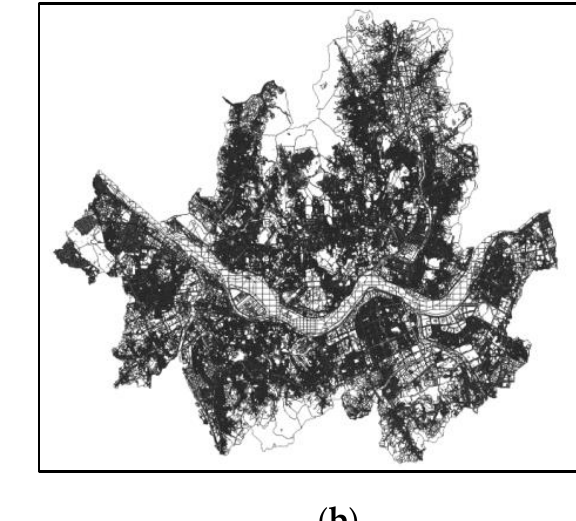
( b ) Figure 4. Map of Busan, Korea: ( a ) Administrative districts [34]; ( b ) vector image on a GIS application . 3.2.2. Depot Locations In the two cities, depot locations are based on UDCs, hub terminals for national postal services, and some large shopping malls. Deliveries starting from the UDCs or postal hubs are reasonable from a logistics point of view, but setting a shopping mall as depot location may seem contrary. However, this reflects the booming demand in last-mile delivery ser- vices, which have increased significantly during the COVID-19 pandemic. The spatial data for the depot locations are obtained from shared data produced by various public institutions in Korea. Locations for UDCs, postal hub terminals and mega shopping malls are shared by the Korean National Logistics Information Center. Spatial data for postal hub centers and shopping malls are from the Korean Ministry of Science and ICT (Information and Communications Technology) and the Korean Land and Geo- spatial Informatrix Corporation, respectively. In Figures 5 and 6, large markets are denoted as blue squares. Among them, one for Seoul and one for Busan are randomly chosen for the benchmark creation. Similarly, for the UDCs and postal hubs, one of each are selected for the Seoul instances, and one of each is selected for the Busan instances.